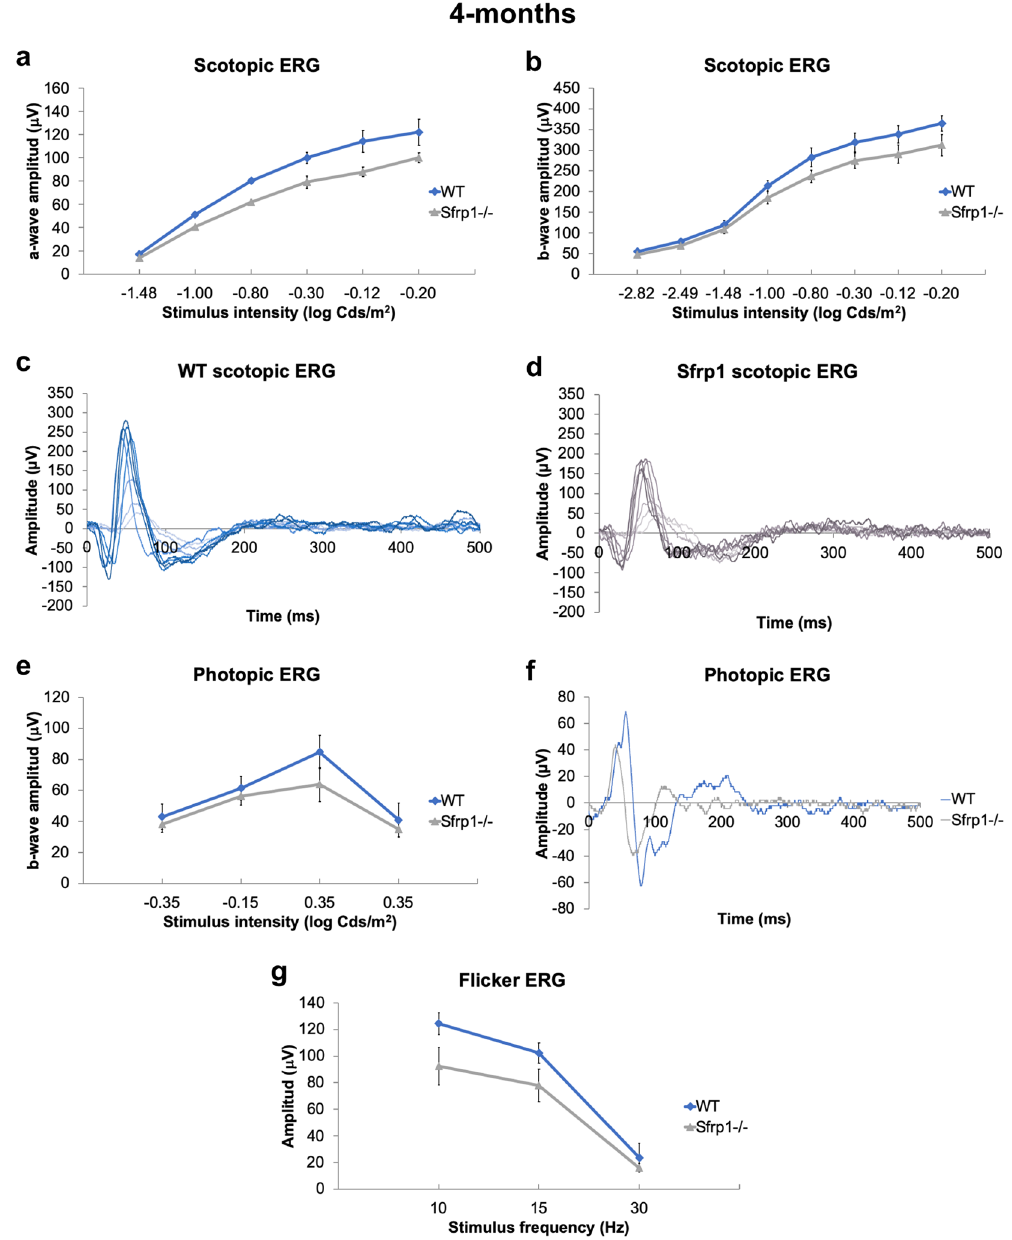
Figure 2. Sfrp1 − / − mice have a slightly reduced visual function. ( a – d ) The graphs and traces of representative recordings show the a- and b-wave amplitude ( µ V; defined in Fig. S2) of the scotopic ERG (rods, a – d ) and the b-wave amplitude of photopic ERG (cones, e , f ) from 4 months-old wt and Sfrp1 − / − animals to flash light stimuli of increasing brightness (cd/m 2 ). ( e ) The graph shows the amplitude response ( µ V) to flicker stimuli of increasing frequencies (Hz). No significant changes were detected (Mann-Whitney U test) but mutant mice show a reduced